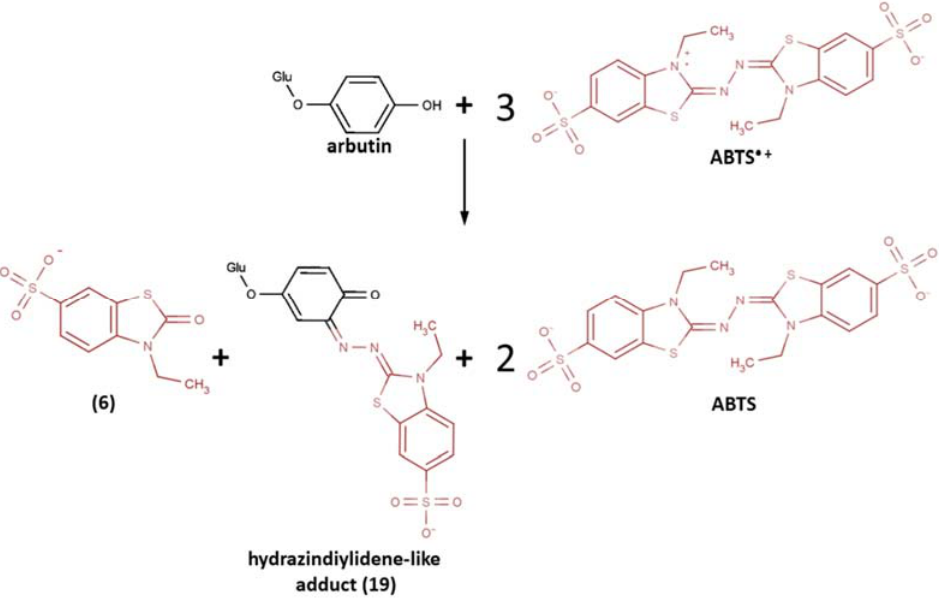
Figure 9. The reaction of ABTS • + with arbutin [129]. Copyright 2016, adopted with permission from American Chemical Society.